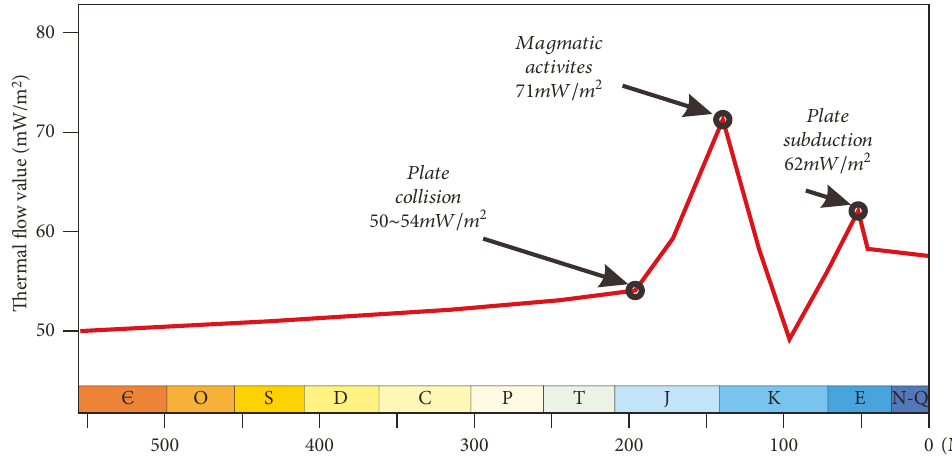
Figure 10: Value of the paleo-heat fl ows in Xiuwu Basin. Data is referred to Li et al.